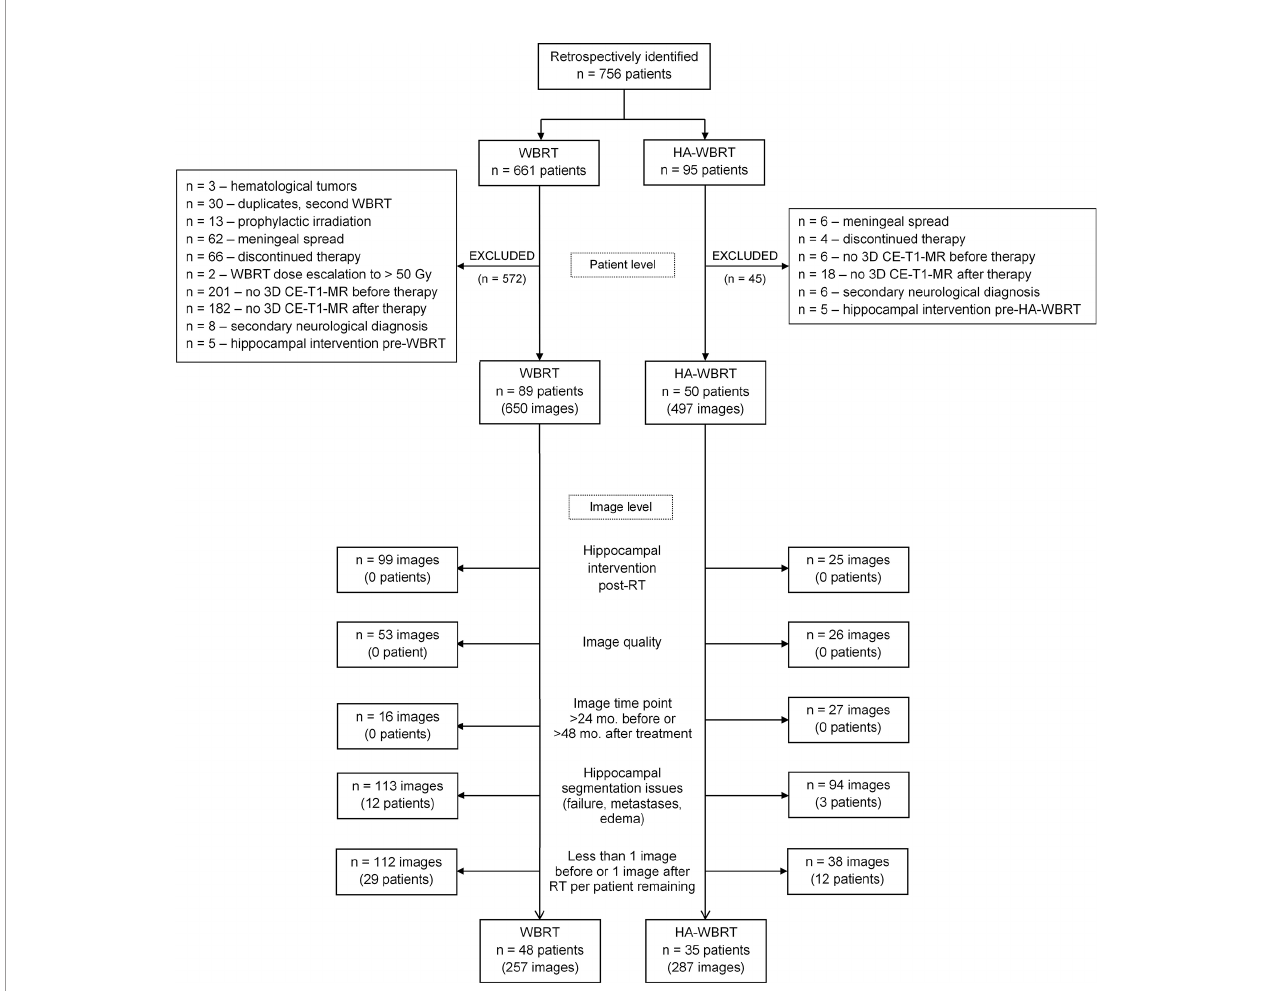
FIGURE 1 | Flowchart of patient selection. CE-T1-MR, contrast-enhanced T1-weighted magnetic resonance; HA-WBRT, hippocampus-avoidance whole-brain radiation therapy; RT, radiation therapy; WBRT, whole-brain radiation